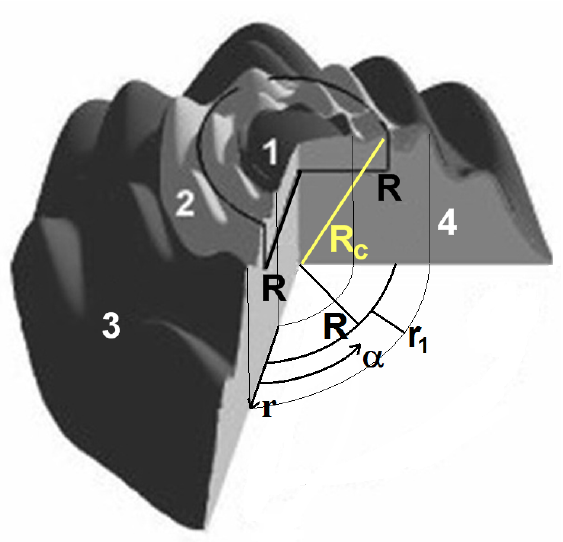
Fig. 7: A schematic of the plant shoot apical meristem (SAM). Cells form but primorida do not form at the center of the SAM (Region 1). Region 2 is the annular generative region where primoria form. In Region 3, no new primordia form, but there is active cell generation and